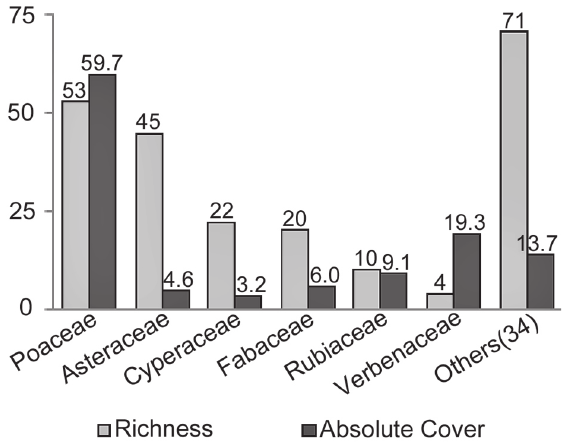
Figure 2 - Richness of species and total vegetation cover per family, recorded in 16 sites distributed in four subregions in grasslands of the South Brazilian coastal plain.